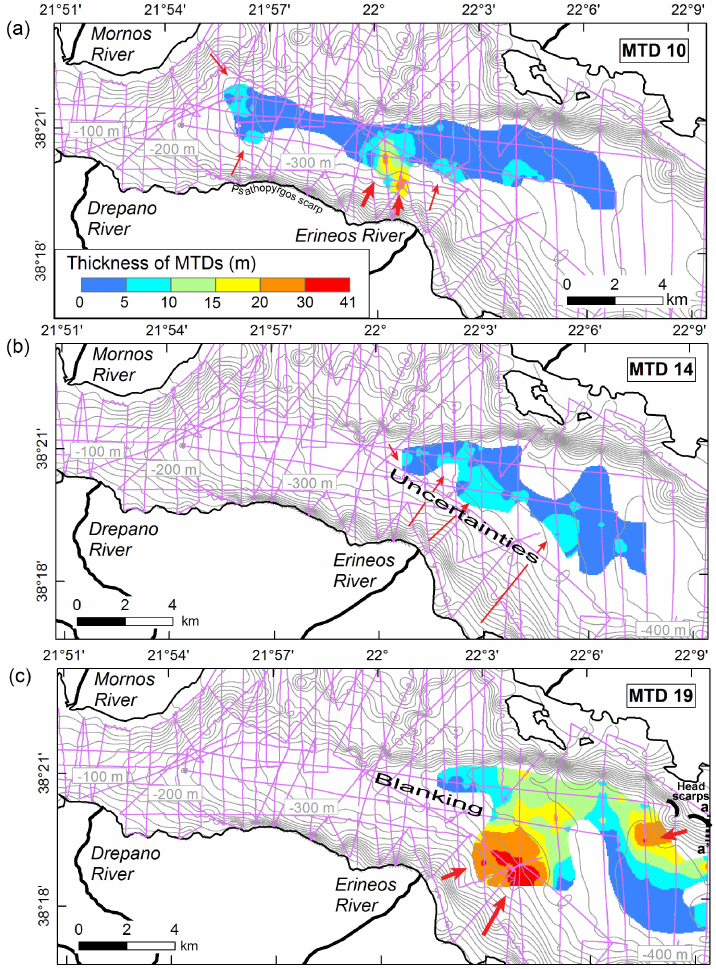
Figure 7. Thickness of the largest MTDs deduced from the interpretation of sparker seismic profiles with probable sediment paths indicated by red arrows (bold arrow: main sources). Contours represent the sea floor bathymetry interpolated from the sparker data (one line every 20m). (a) MTD 10 in sliding event C, the largest MTD from the sliding event C. (b) Thickness of MTD 14, the largest of the two MTDs that define the sliding event D. (c) The largest MTD from the presented inventory (MTD 10, sliding event F). The black bold lines represent two landslide head scarps likely linked to the MTD. The dotted line shows the location of the seismic profile in Fig.